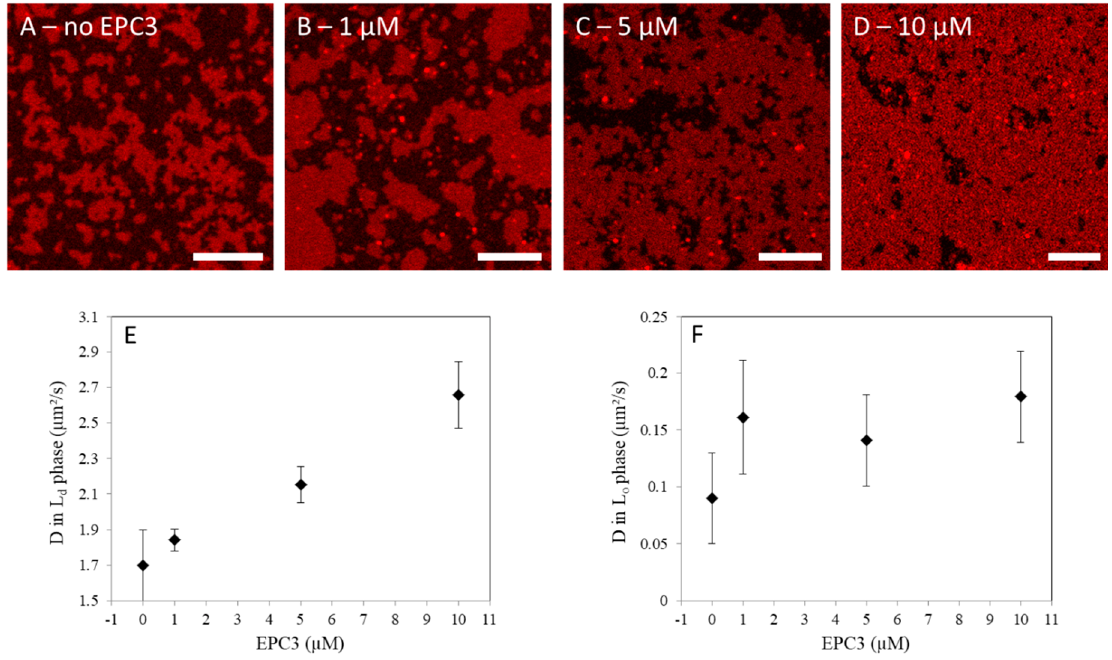
Figure 1. Effect of erufosine (EPC3) on phase-separating model membranes . ( A – D ) Representative confocal fluorescence microscopy images of eggPC/bSM/Chol 4/4/2 molar ratio supported lipid bilayers (SLBs) in the presence of 0, 1, 5, and 10 µM EPC3, respectively. The bilayers were labeled with 0.1 mol% Rhod-DOPE. Darker zones (devoid of Rhod-DOPE) indicate L o regions of the SLB. Images were acquired at RT. Scale bars are 10 µm; ( E – F ) Values of the diffusion coefficients D measured via line-scan fluorescence correlation spectroscopy (lsFCS) in the L d , (E) and L o phase (F) of eggPC/bSM/Chol 4/4/2 molar ratio SLBs in the presence of EPC3. The reported values refer to the diffusion of a fluorescent cholesterol analogue (TF-Chol, 0.01 mol%). Independent experiments were repeated in triplicate and averaged after normalization (see Materials and Methods). Error bars represent standard deviations.